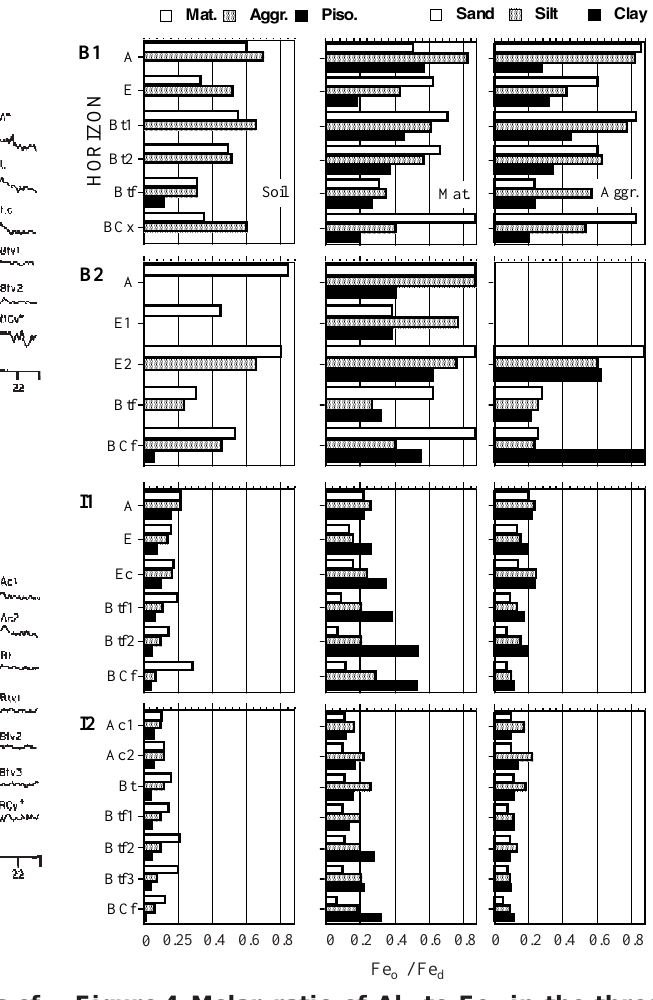
to Fe in the three Figure 4. Molar ratio of Al d d consistency fractions and the particle size fractions of the matrices and water-stable aggregates. Note that the horizontal scale is identical for all graphs and the legend for consistency fractions applies only to graphs in the first